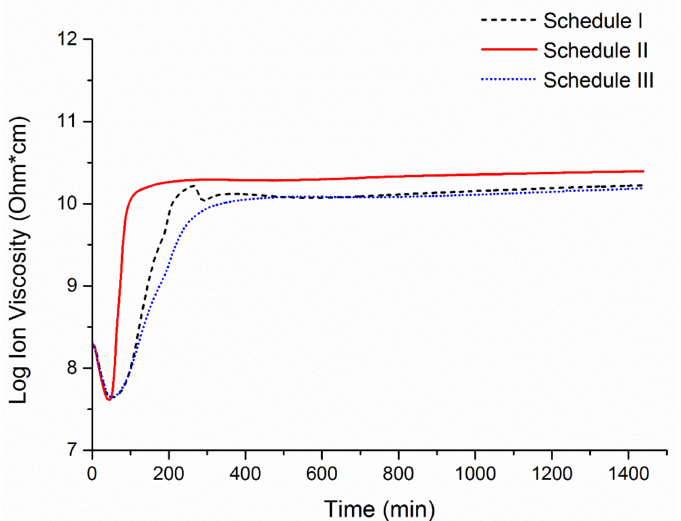
Figure 3. DEA curves of starch composites with composition 8, cured at 2 h 50 min at 120 ◦ C, 21 h at 140 ◦ C (Schedule I), 24 h at 140 ◦ C (Schedule II), and 24 h at 120 ◦ C (Schedule